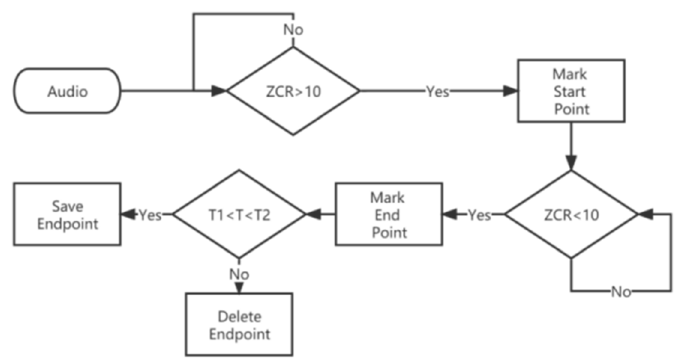
Figure 7. Short-time zero crossing rate endpoint detection method.